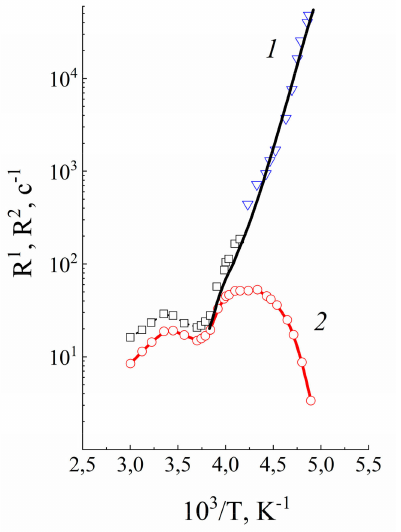
Figure 23. Temperature dependences of spin–lattice ( R 1— curve 2) and spin–spin ( R 2— curve 1) relaxation rates of 1 H water molecule nuclei in Li + ionic form of MF-4SC membrane at water content λ = 20.5 water molecules per sulfonate group (adapted from [37,38]).